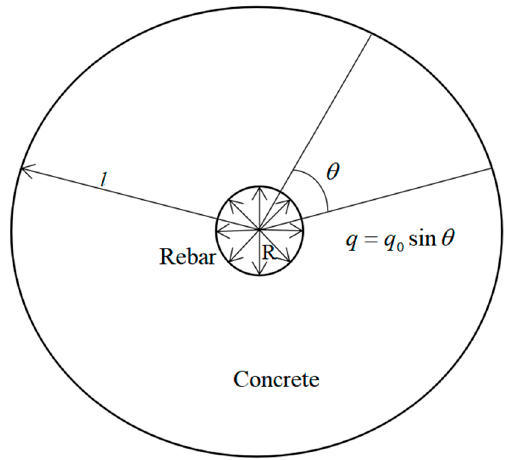
Figure 2. Action of corrosion stress in reinforced concrete.